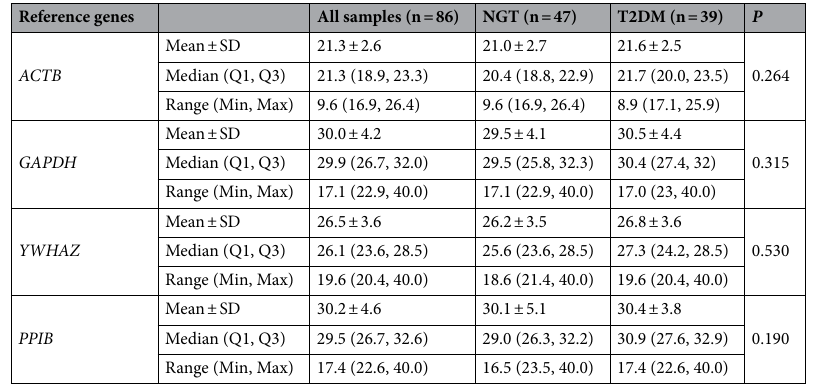
Table 2. Descriptive statistics of raw C t values of the 4 reference genes ( ACTB, PPIB, YWHAZ and GAPDH ) in PBMCs of the 86 study subjects categorized into normoglycemic controls (NGT, n = 47) and Type 2 diabetic patients (T2DM, n = 39). P values are from Mann Whitney